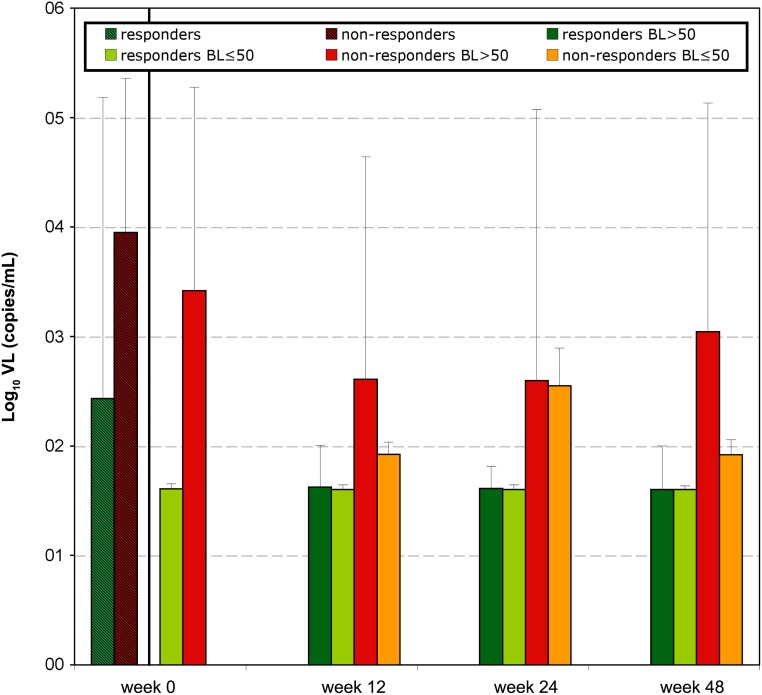
Viral load follow-up of the 108 patients.Depicted data correspond to VL mean values with standard deviations. Week 0: data from 97 patients who subsequently responded to treatment (responders) are represented in striped green; data from 11 patients that subsequently did not respond to treatment at any time (non-responders) are represented in striped red. Week 0, 12, 24, 48: responding patients: data from patients responding to the therapy at the corresponding sampling date are displayed in green: those who started MVC therapy with undetectable VL in light green, and those with baseline (BL) VL above detection limit in dark green; non-responding patients: data from patients not responding to the therapy at the corresponding sampling date are displayed in red (those with detectable baseline VL) and in orange (those with undetectable baseline VL).